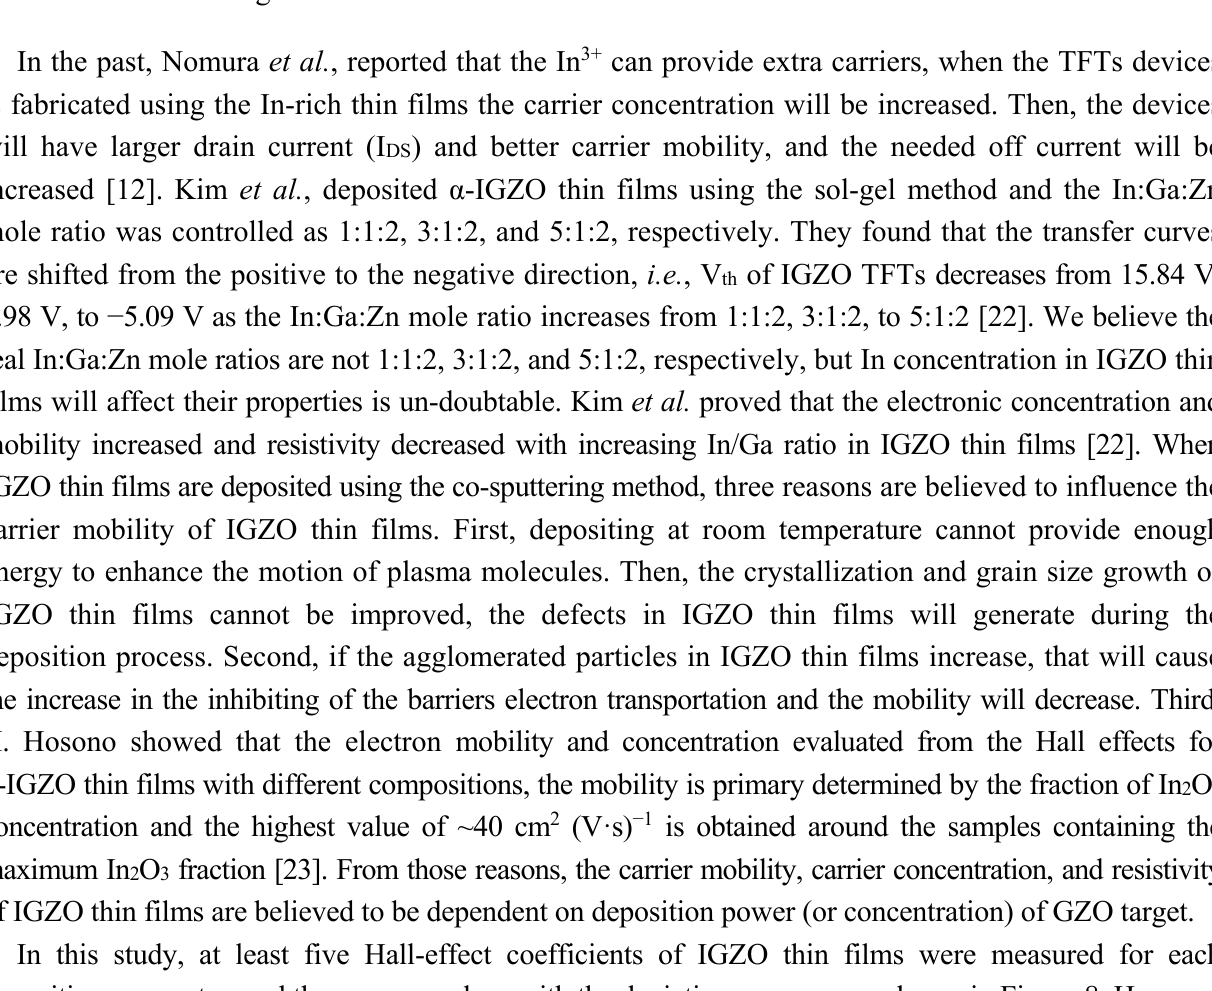
Figure 7. Α 2 vs. h ν -E g Tauc plots of IGZO thin films as a function of deposition power of GZO ceramic